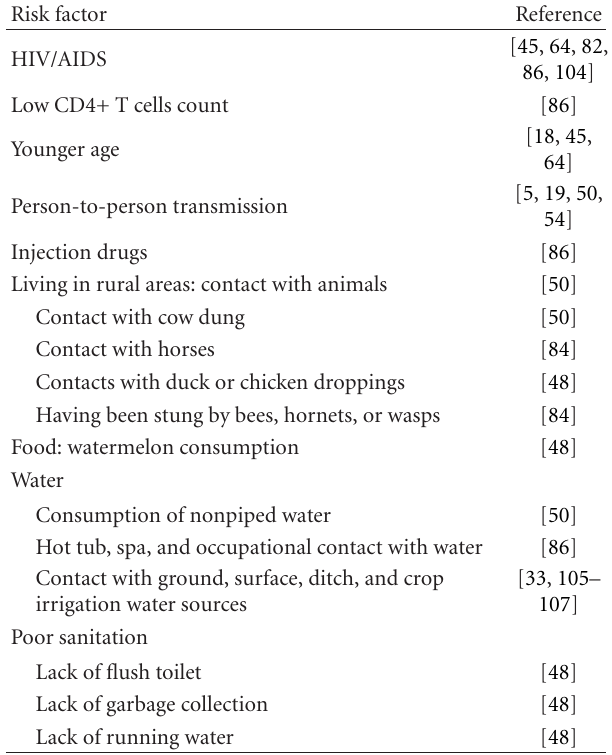
Table 2: Risk factors associated with Enterocytozoon bieneusi infec-